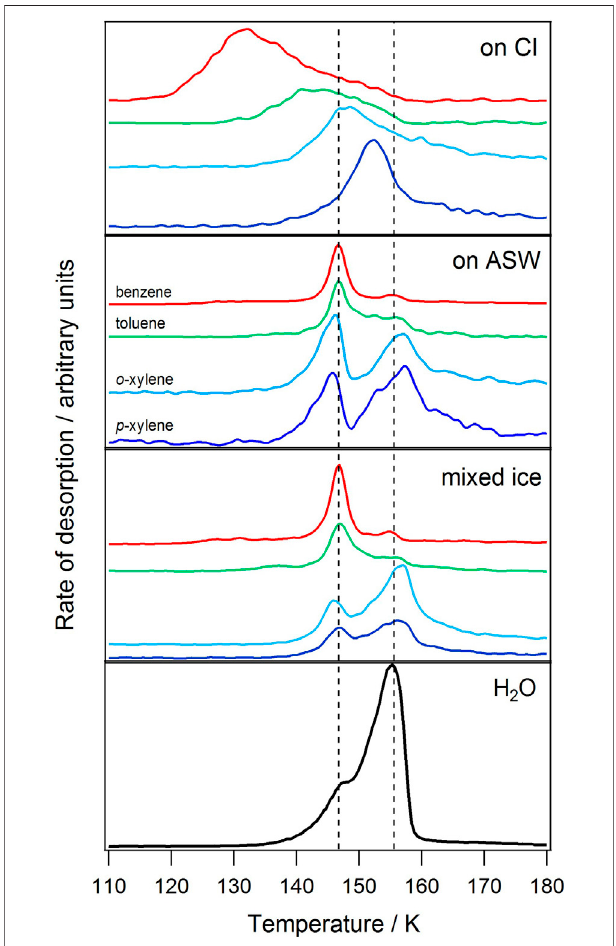
FIGURE 3 | TPD spectra of 5 L m of benzene, toluene, o -xylene and p -xylene in different ice con fi gurations, shown in Figure 2 , deposited on HOPG between 25 and 30 K. From top to bottom: layered ices consisting of the aromatic molecule adsorbed on top of 50 L m CI, on top of 50 L m ASW, and binary mixtures of the aromatic molecule (9%) with ASW (total 55 L m ). The bottom panel shows the desorption of pure water from HOPG.